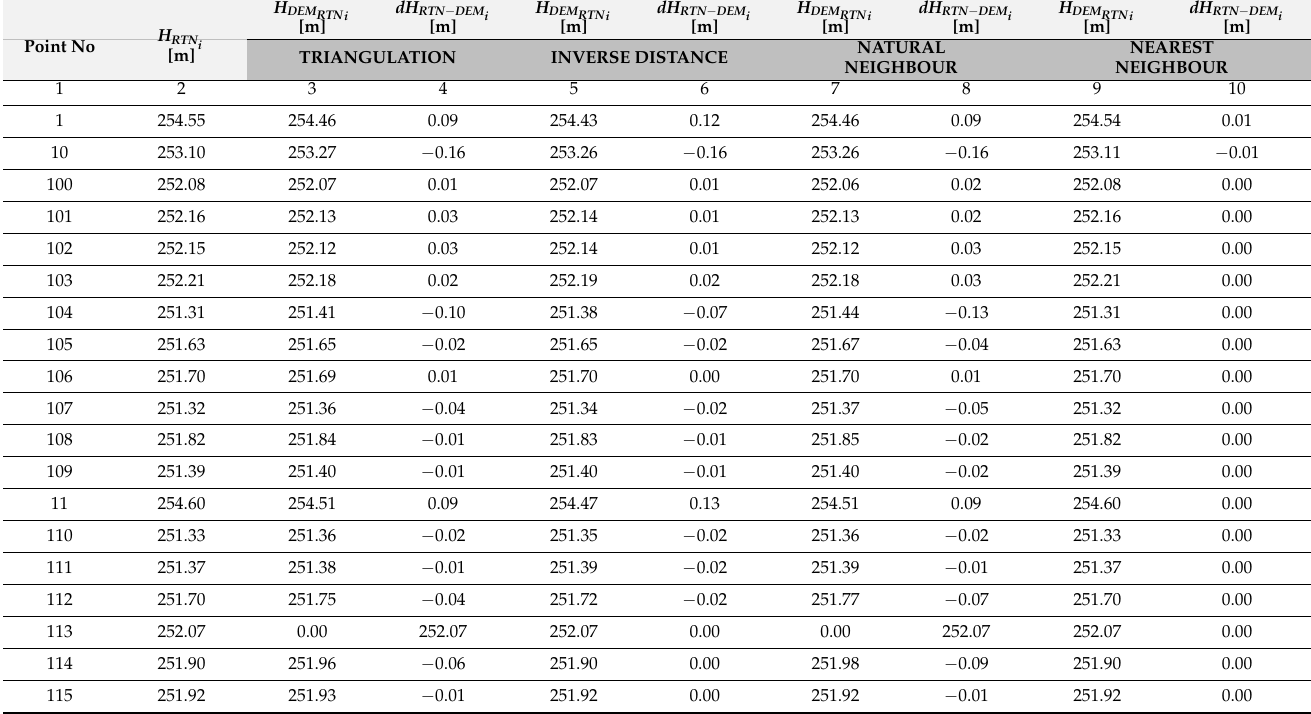
Table A2. Comparison of point heights read automatically from the DEM rasters created from